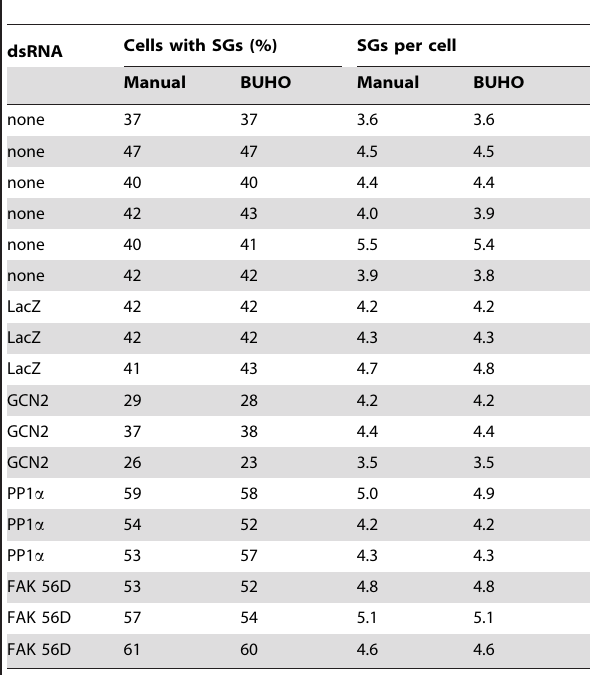
Table 3. Summary of manual and BUHO analysis for the identification of SG